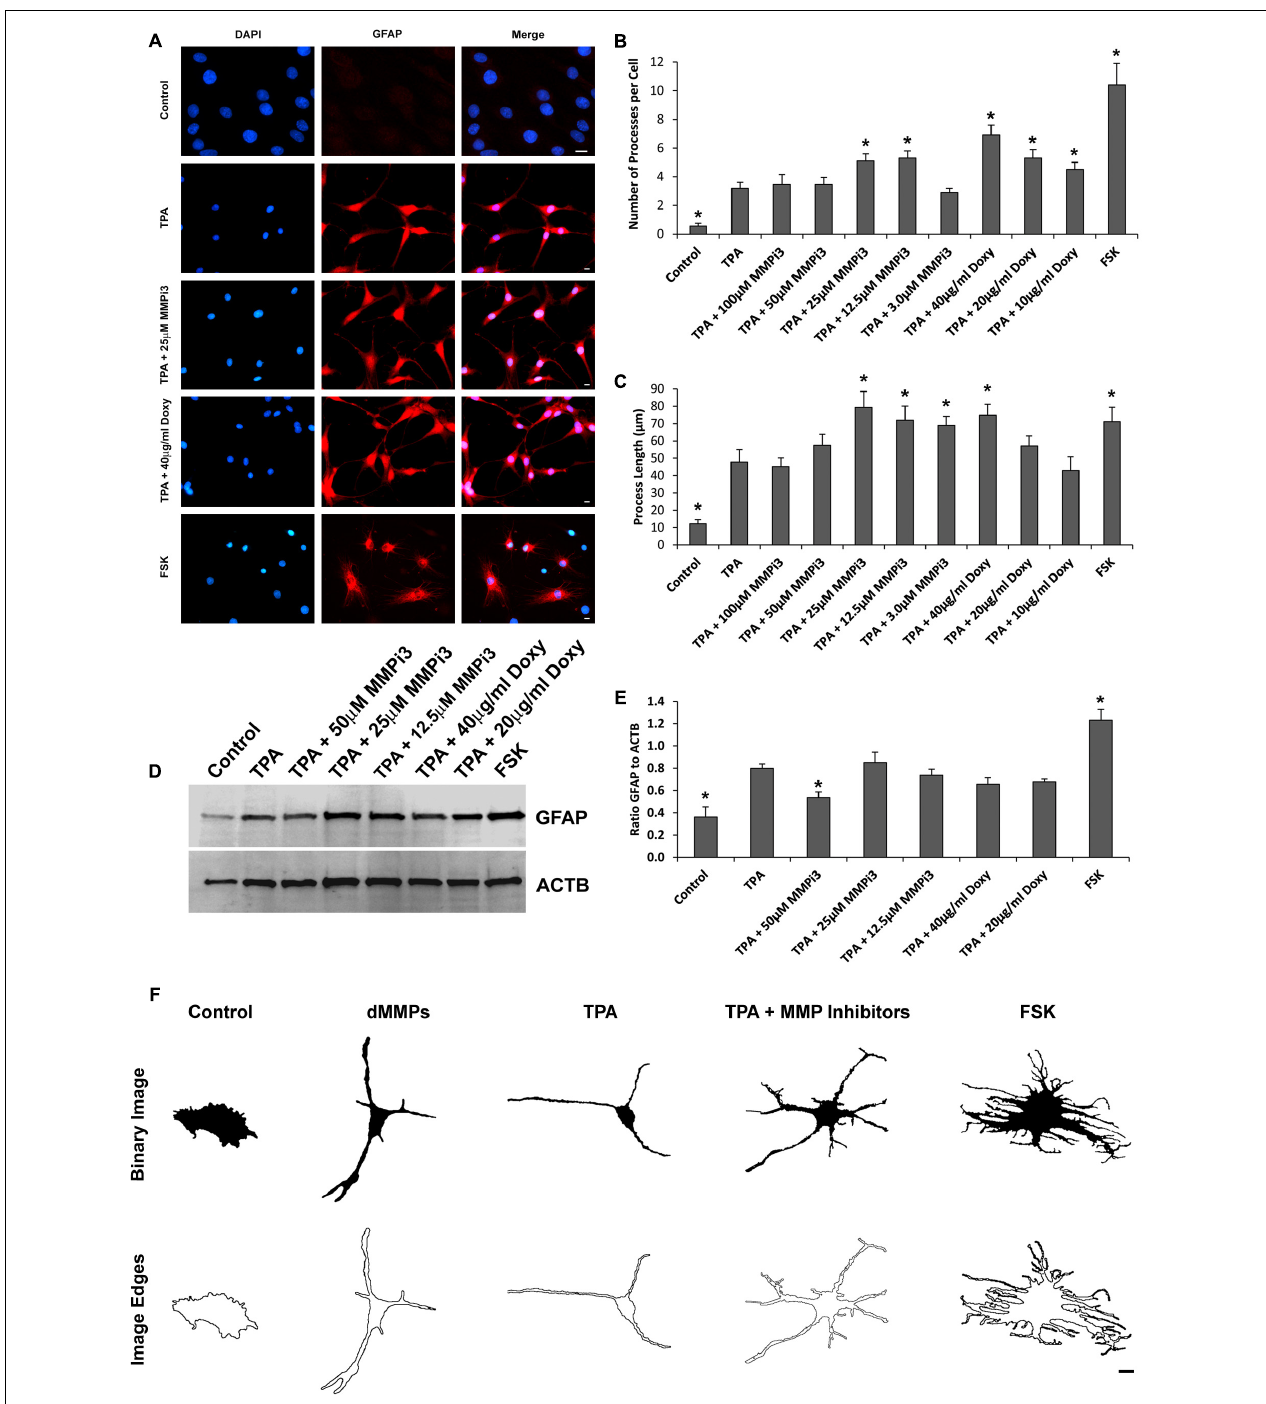
FIGURE 9 | Matrix metalloproteinases inhibition impacts C6 glial cell morphology. (A) C6 cells under control conditions, treated with TPA, TPA plus various concentrations of MMP inhibitor III (MMPi3), TPA plus various concentrations MMP inhibitor doxycycline (Doxy), or MMP suppressor forskolin (FSK). Shown in blue is DAPI nuclear stain, in red is GFAP. Scale bar = 10 µ m. (B) Number of processes per cell (Mean ± SE) in Control, TPA treated, TPA plus MMPi3, TPA plus Doxy, and FSK. (C) Process length ( µ m) (Mean ± SE) in Control, TPA treated, TPA plus MMPi3, TPA plus Doxy, and FSK. (D) Western blots of GFAP and β -Actin (ACTB) levels in C6 lysates from Control, TPA, TPA plus MMPi3, TPA plus Doxy, and FSK treated cells. (E) Ratio (Mean ± SD) of GFAP and ACTB taken from optical density analysis of western blot data. Data are averaged across three independent experiments. * Represents significant difference compared to control at p < 0.05. (F) Modulation of MMPs results in distinct C6 glial cell phenotypes. Shown are representative Binary Images and the Image Edges of a C6 cell expressing dMMPs, treated with TPA, TPA plus MMP inhibitors, or FSK. Scale bar = 10 µ m.